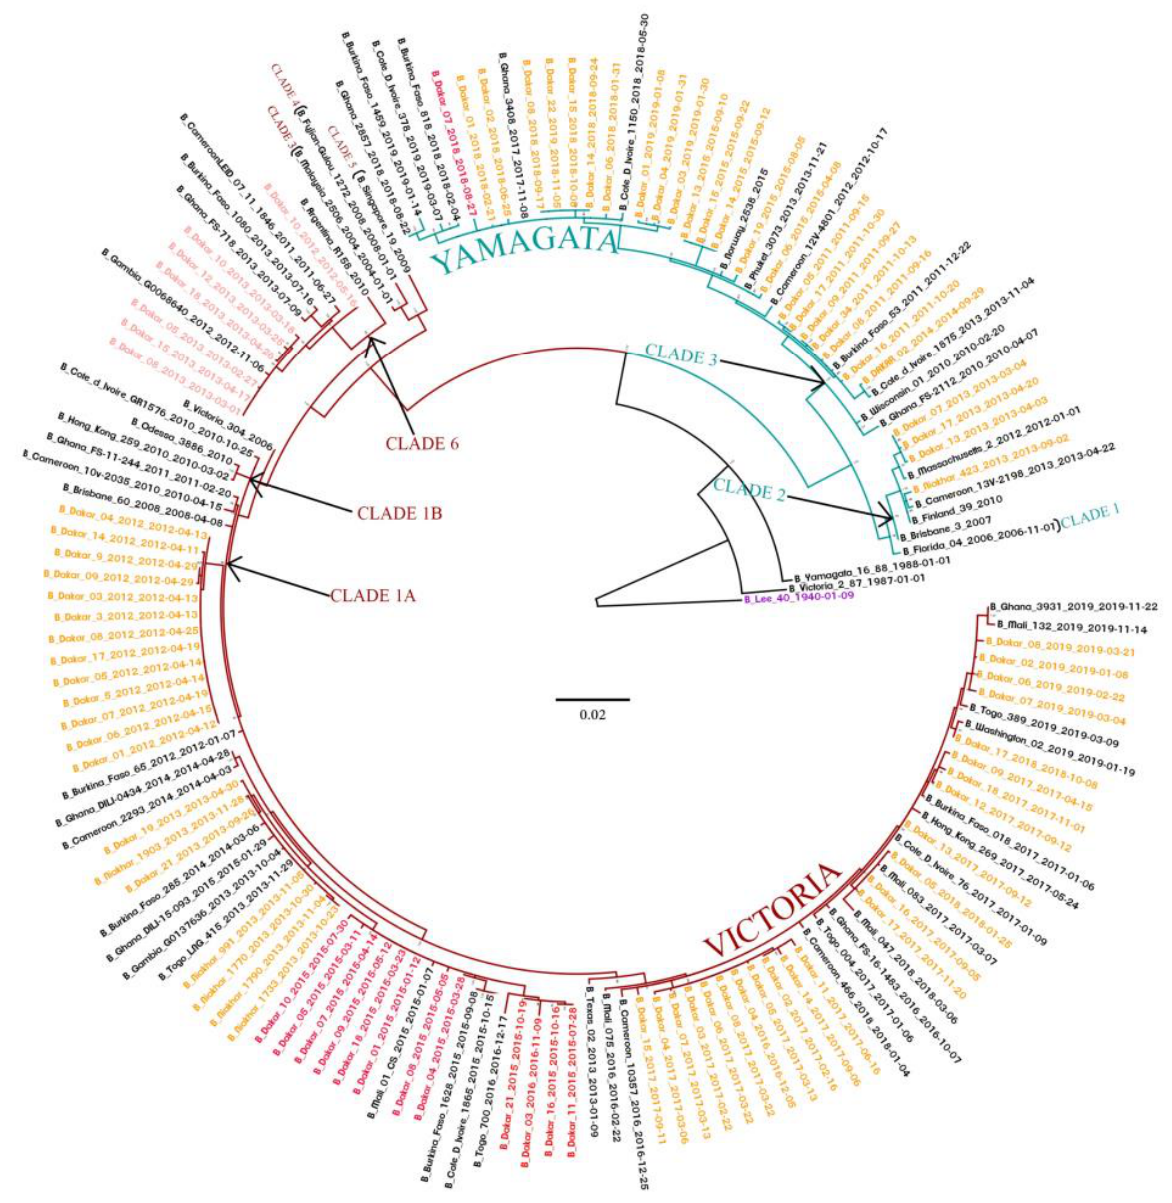
Figure 3. The maximum likelihood (ML) tree for the NA gene of IBV circulating in Senegal. The ML tree was calculated using the IQ-TREE software version 1.6.12 [18] and visualized using the Figtree software version 1.4.4 [19]. A bootstrap number of 1000 was used, and the software was responsible for defining the correct model used. Strain B/Lee/1940 was used in order to root the tree. Senegalese strains, inter-lineage recombinant strains, and intra-lineage recombinant stains are respectively indicated in orange, red and